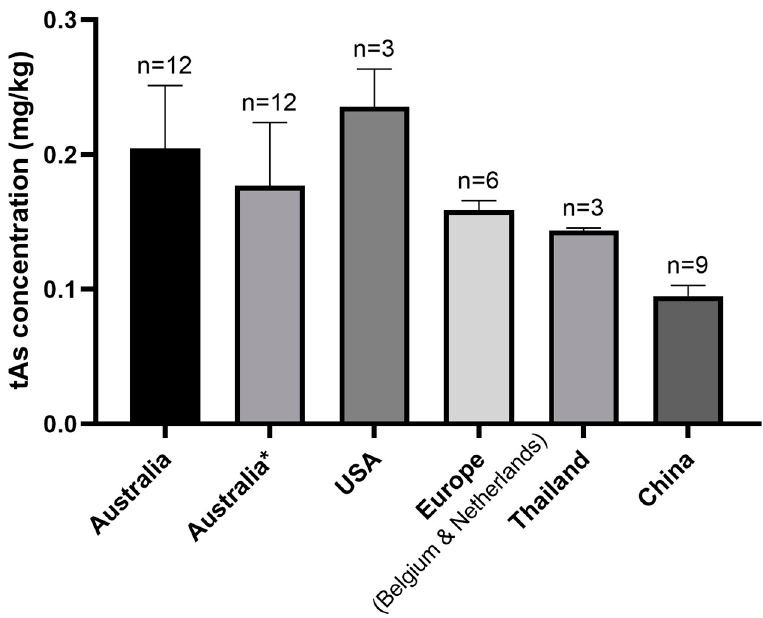
Figure 4. Mean and standard error of tAs concentrations of infant rice-based foods from different countries of origins of products purchased in Melbourne, Australia.